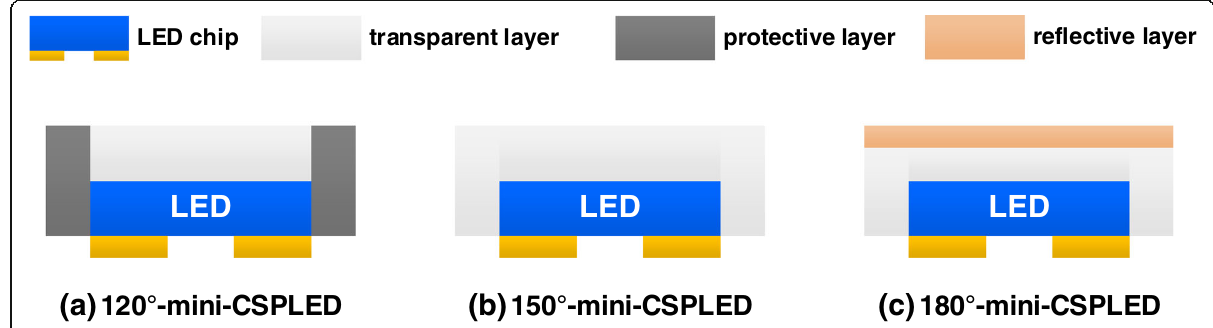
Fig. 1 Schematic diagrams of three kinds of mini-CSPLED emission angle structure. a 120° mini-CSPLED, b 150° mini-CSPLED, and c 180° mini-CSPLED